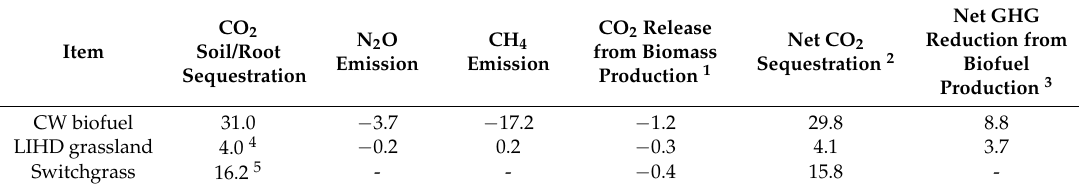
Table 2. Net CO 2 sequestration, net greenhouse gas (GHG) reduction for the CW, the LIHD grassland, and switchgrass (positive value means sequestration, while negative value indicates release, unit: Mg CO 2 eq. ha − 1 year − 1